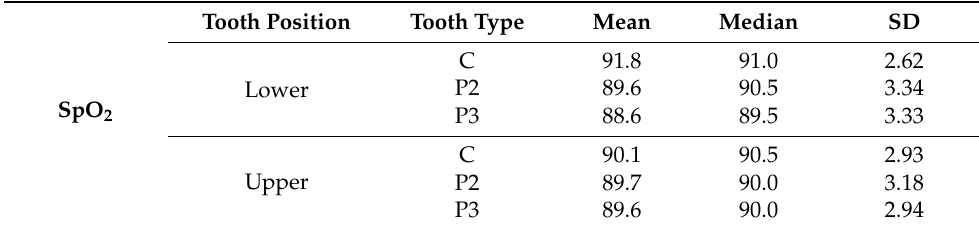
Table 1. Mean SpO 2 values recorded in healthy primary canines and premolars. Tooth